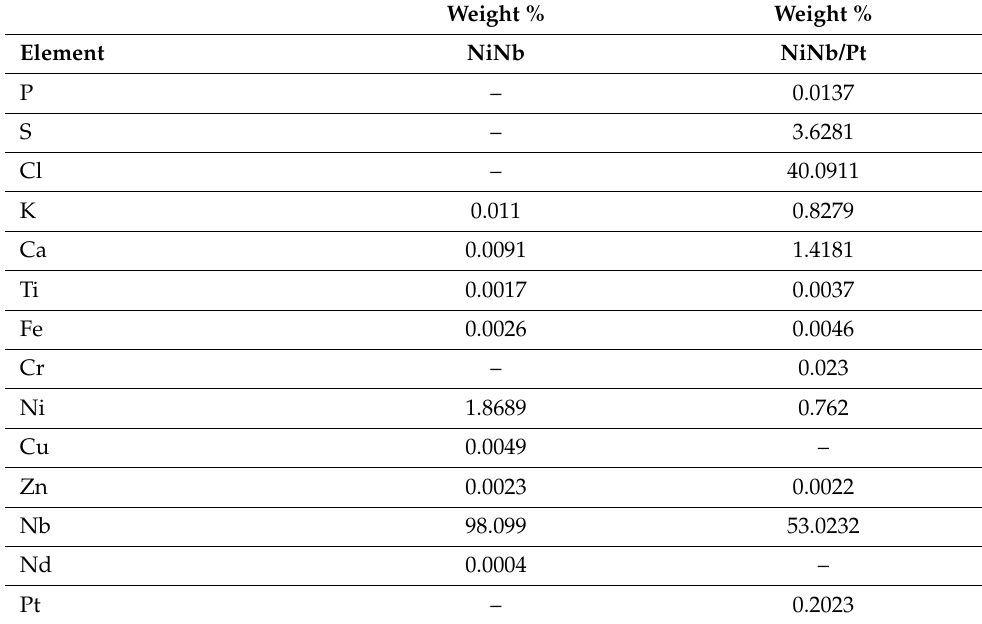
Table 1. Results obtained from the TXRF analysis of the catalysts (average values). Weight % Weight %